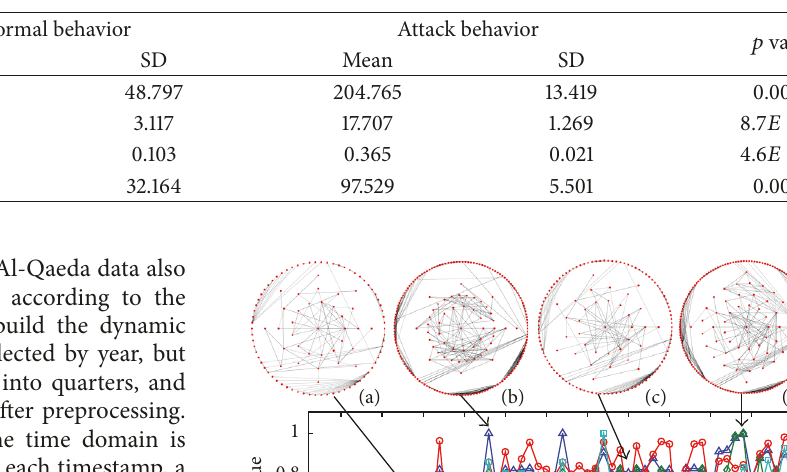
Table 2: Comparison of selected measures between networks with Normal and Attack behaviors .